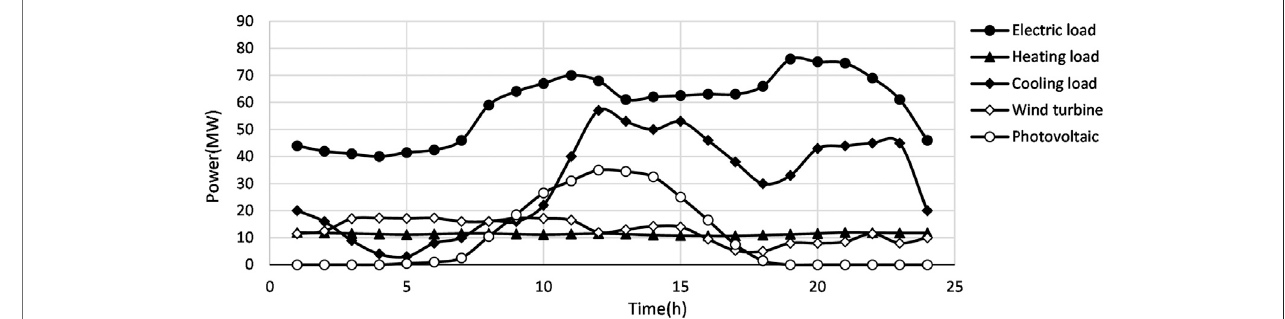
FIGURE 4 | Power, heating and cooling load, and renewable energy curves of a typical day in summer.